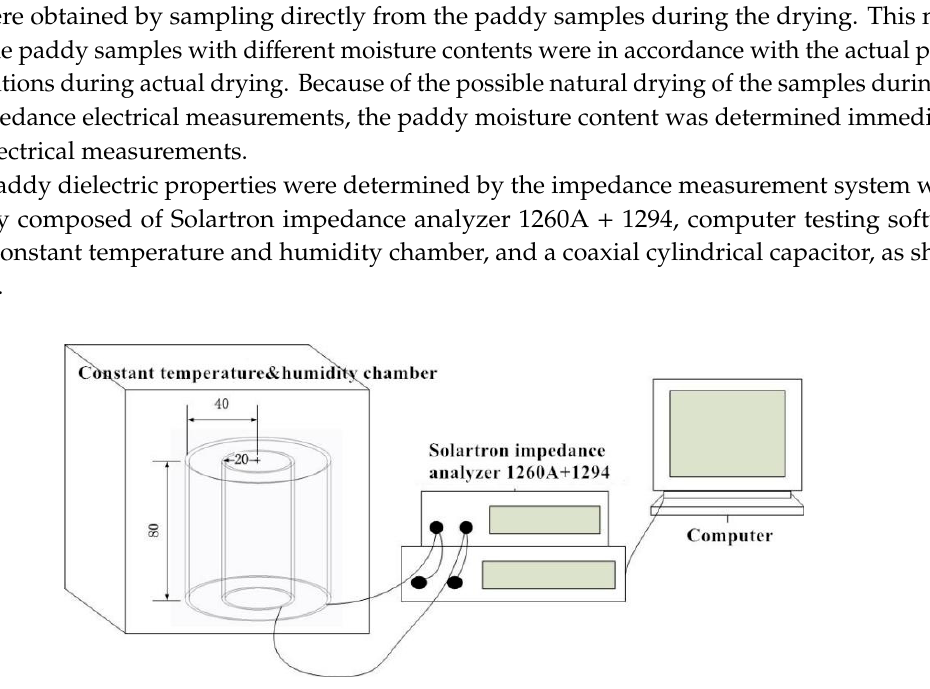
Figure 1. Impedance measurement system (length unit: mm).